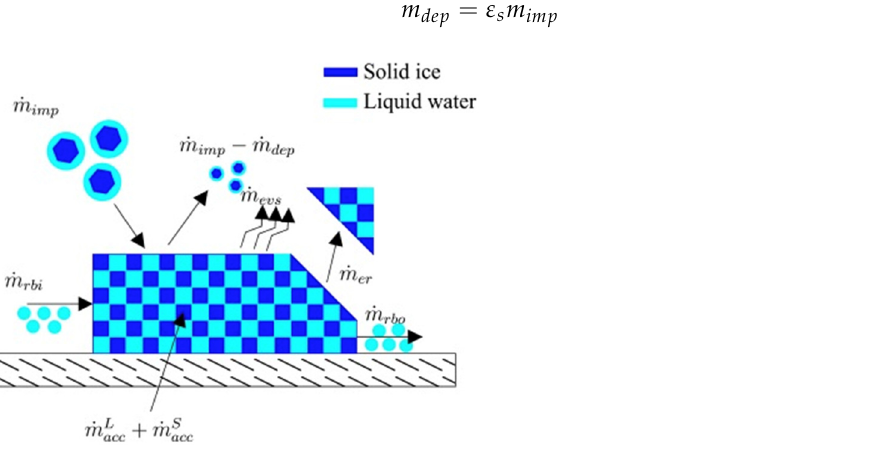
where η m is the melting ratio of the impinging ice